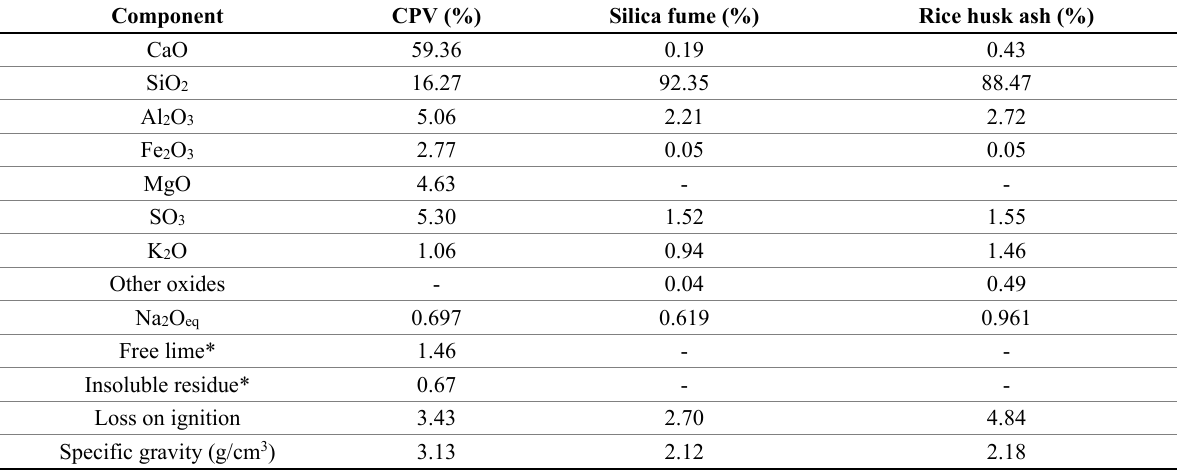
Table 2. Chemical composition (oxides %) and physical properties of materials.